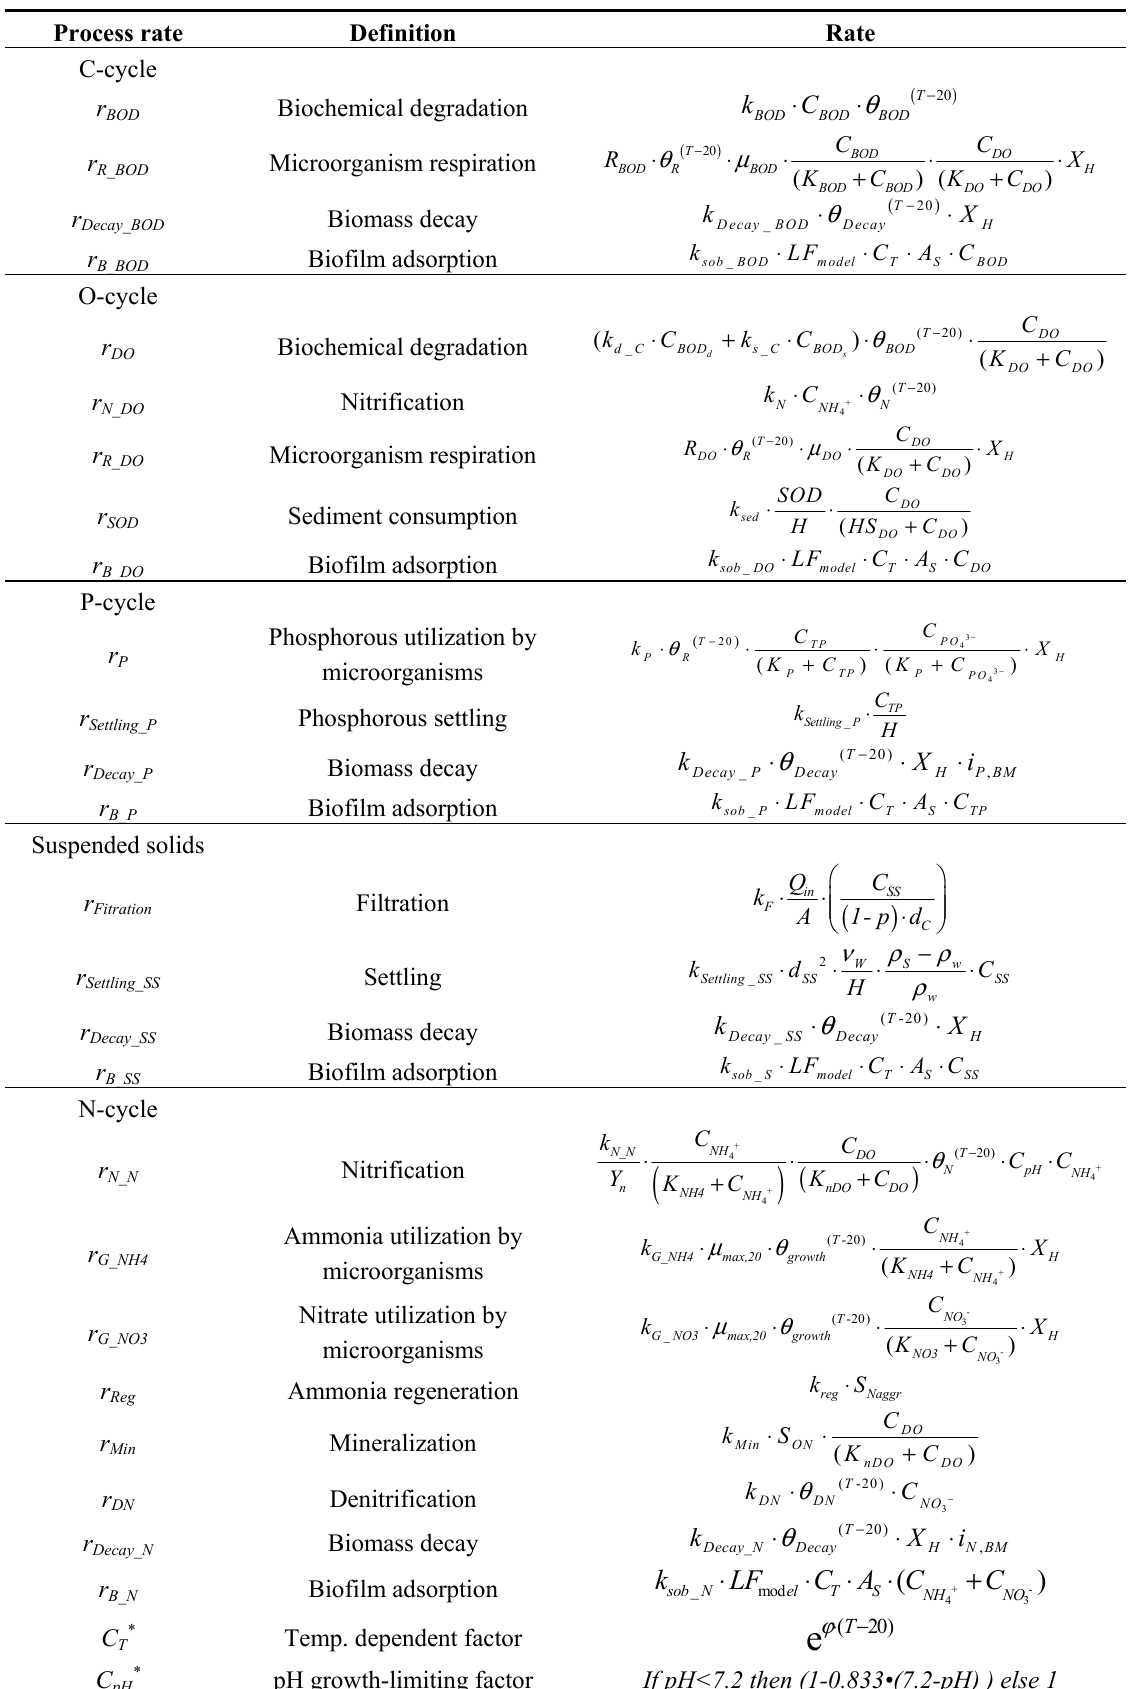
Table 4. Parameters and reaction kinetics of different nutrient cycle processes involved in the CW waste treatment